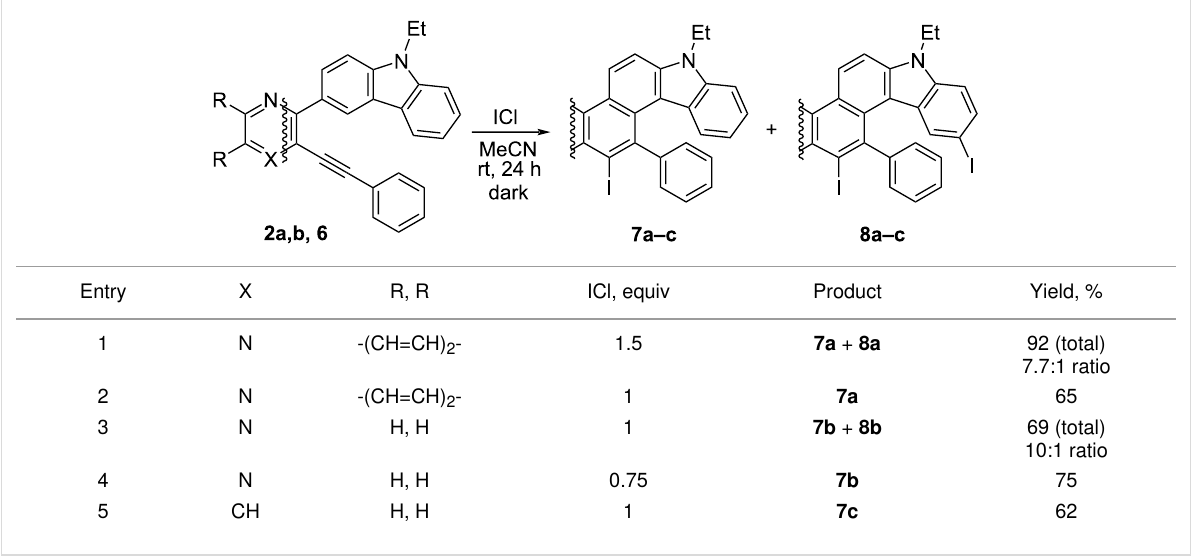
Table 3: ICl-induced cyclyzation of compounds 2 and 6 .